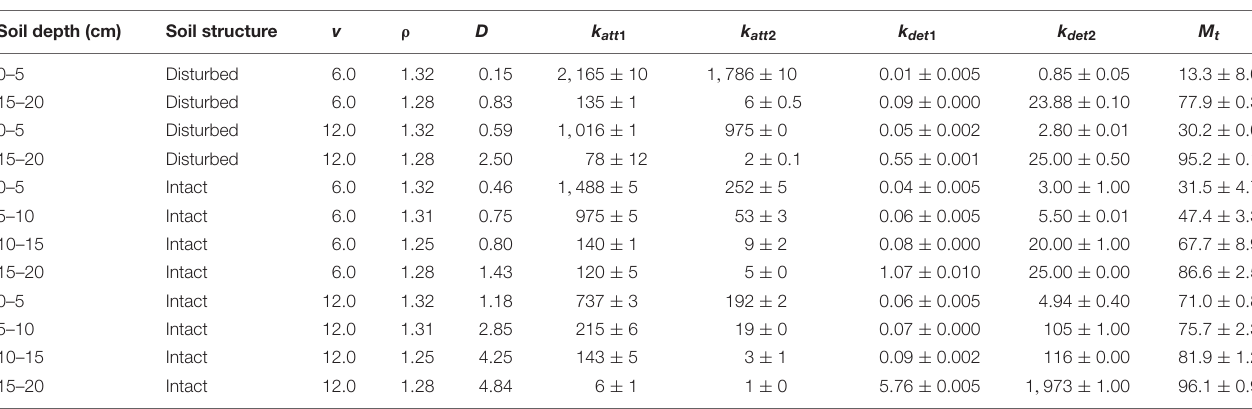
TABLE 1 | Fitted parameters and mass recovery of bacterial transport